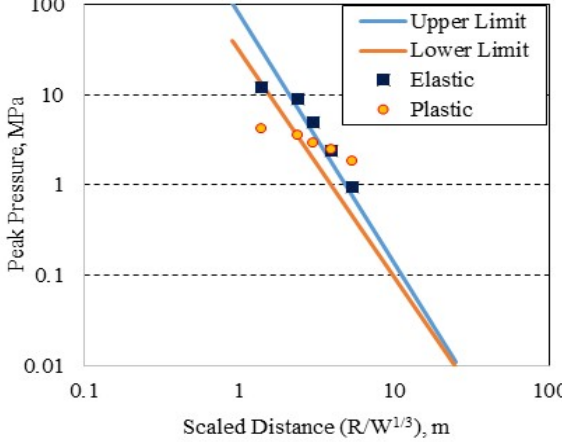
Figure 5: Results of the empirical and finite element.